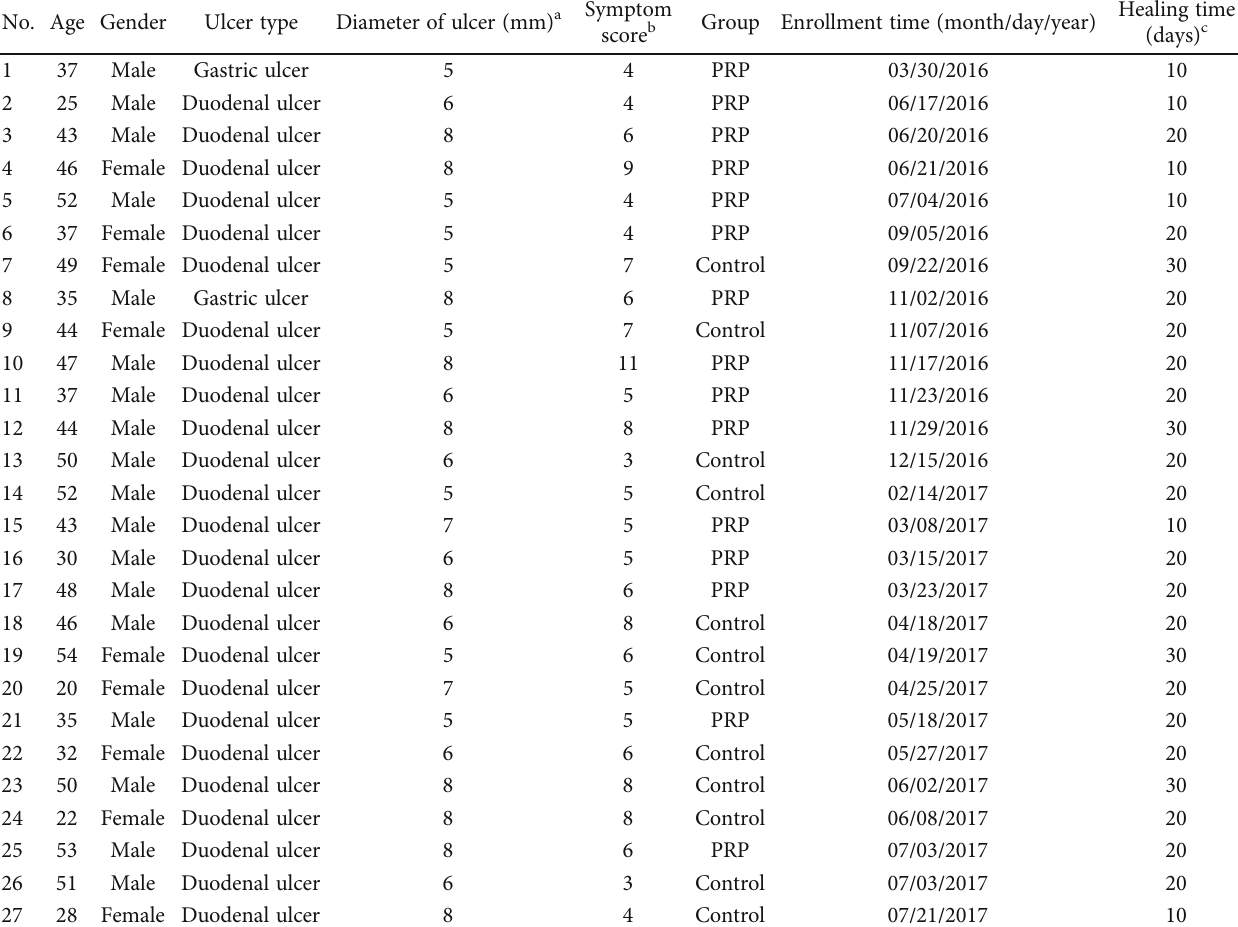
Table 1: The personal information and clinical characteristics of